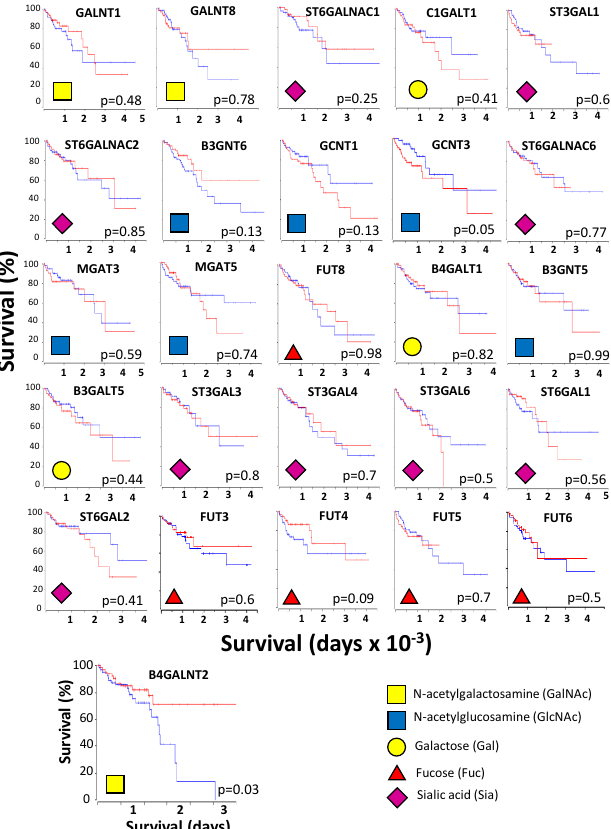
Figure 2. Kaplan–Meier survival plots of patients expressing high or low glycosyltransferase mRNA levels. Curves were generated by the OncoLnc website using the 15% higher (red lines) and 15% lower expressions (blue lines) of the indicated genes. The sugar transferred by each glycosyltransferase is indicated by the code in the insert.